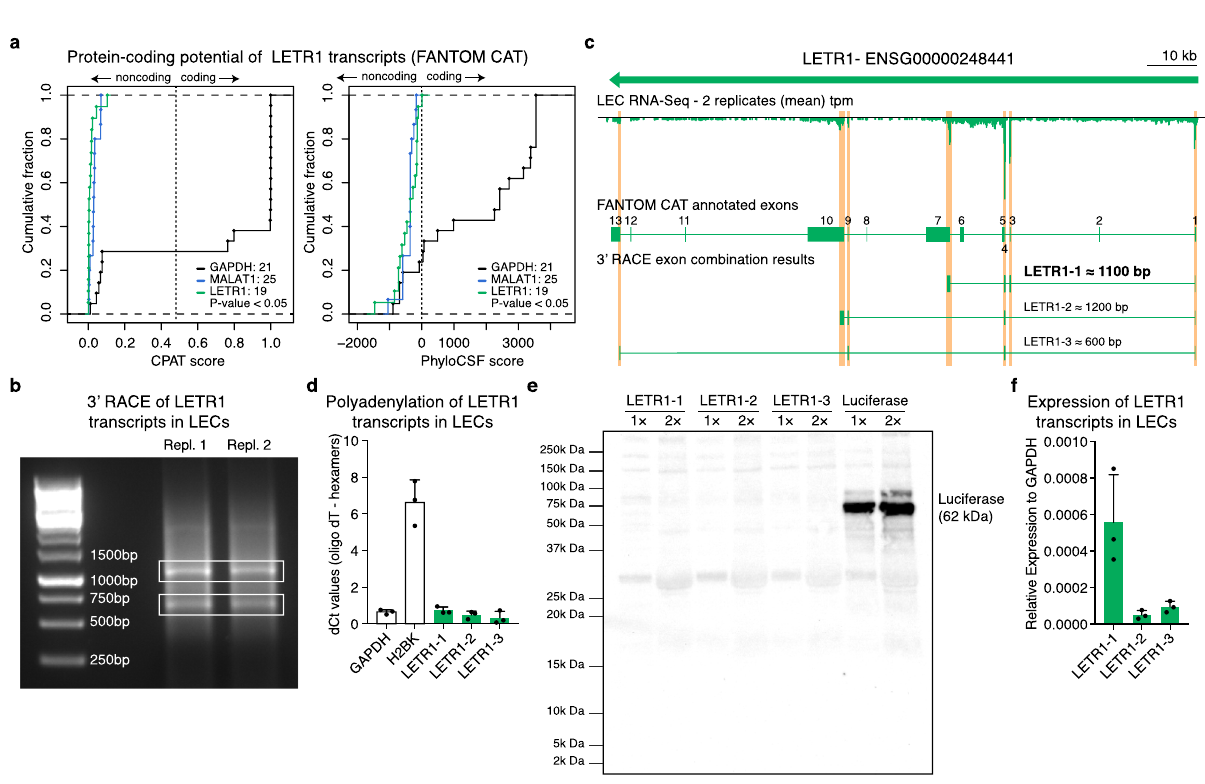
Fig. 4 LETR1 is a bona fi de lncRNA expressing three main transcripts in LECs. a Cumulative fraction analysis of Coding Potential Assessment Tool (CPAT) 54 (left) and Phylogenetic Codon Substitution Frequencies (phyloCSF) 55 (right) scores of LETR1 (19 transcripts), GAPDH (21 transcripts, known protein-coding gene), and MALAT-1 (15 transcripts, known lncRNA). P values were calculated using the two-sample Kolmogorov – Smirnov test. b Agarose gel showing the results after 3 ′ Rapid Ampli fi cation of cDNA Ends (RACE) (two replicates). White boxes: two excited bands further processed following the SMARTER 3 ′ RACE protocol. c Schematic representation of 3 ′ RACE results depicting the three LETR1 transcripts expressed in LECs: LETR1-1 (~1100 bp), LETR1-2 (~1200 bp), LETR1-3 (~600 bp). RNA-Seq signal was visualized through the Zenbu genome browser 123 . LETR1 transcript sequences are listed in Supplementary Data 8. d Comparison of qPCR levels of GAPDH (polyA + ), H2BK (polyA − ), LETR1-1, LETR1-2, LETR1-3 after cDNA synthesis with either oligodT or random hexamers primers in neonatal LECs derived from three donors. e In vitro translation assay results of LETR1-1, LETR1-2, and LETR1-3. A construct containing the luciferase gene (62 kDa) was used as positive control. Uncropped western blot image is shown in Supplementary Figure 9. f Expression levels of LETR1-1, LETR1-2, and LETR1-3 in neonatal LECs derived from three donors. Data are presented as mean values + SD ( n = 3 in d and f